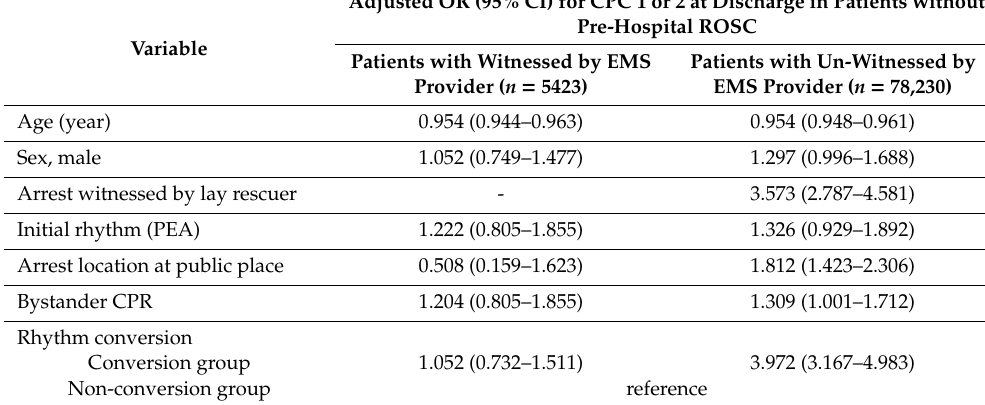
Table 6. Multiple logistic regression analysis for outcomes in OHCA patients with initial non-shockable rhythm without pre-hospital ROSC according to the state of being witnessed by an EMS